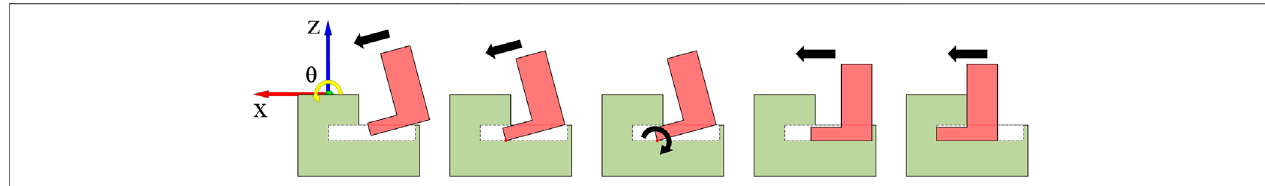
FIGURE 3 | The insertion trajectory of A (1)